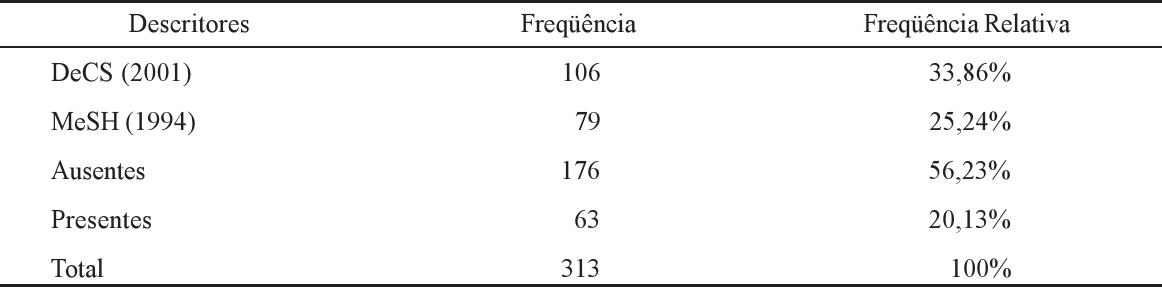
TABELA 2 - Freq(cid:252)Œncia absoluta e relativa dos descritores em l(cid:237)ngua inglesa usados em artigos de revistas nacionais de angiologia e cirurgia vascular no per(cid:237)odo de 1995 a